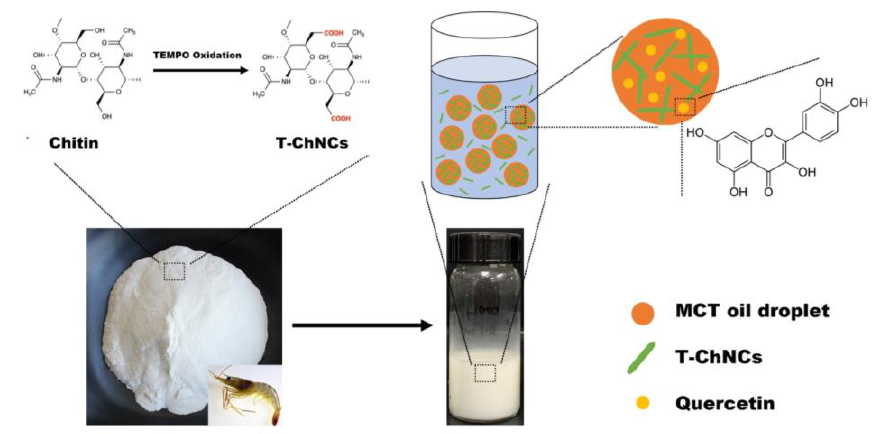
Figure 1. The scheme of chitin powder extracted from shrimp shells and modified by TEMPO oxidation for stabilization of Pickering emulsions and as quercetin carriers.